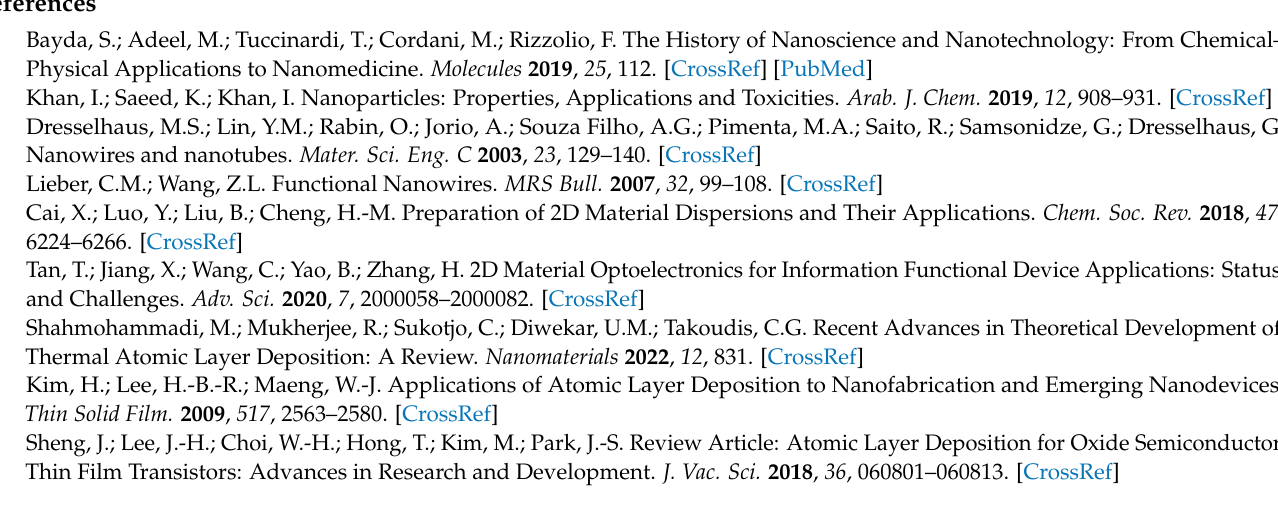
circuit for eliminating the influence of the drift signal; Figure S4: FEM results depicting top-view